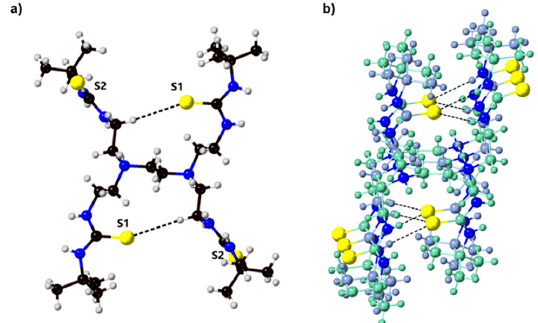
Figure 3. ( a ) X-ray crystal structure of 3 (black: carbon, grey: hydrogen, blue: nitrogen, yellow: sulfur) and ( b ) intermolecular hydrogen bonding between 3 forming columns of the receptors in the solid-state (each receptor is outlined in either teal or blue-grey, yellow: sulfur).